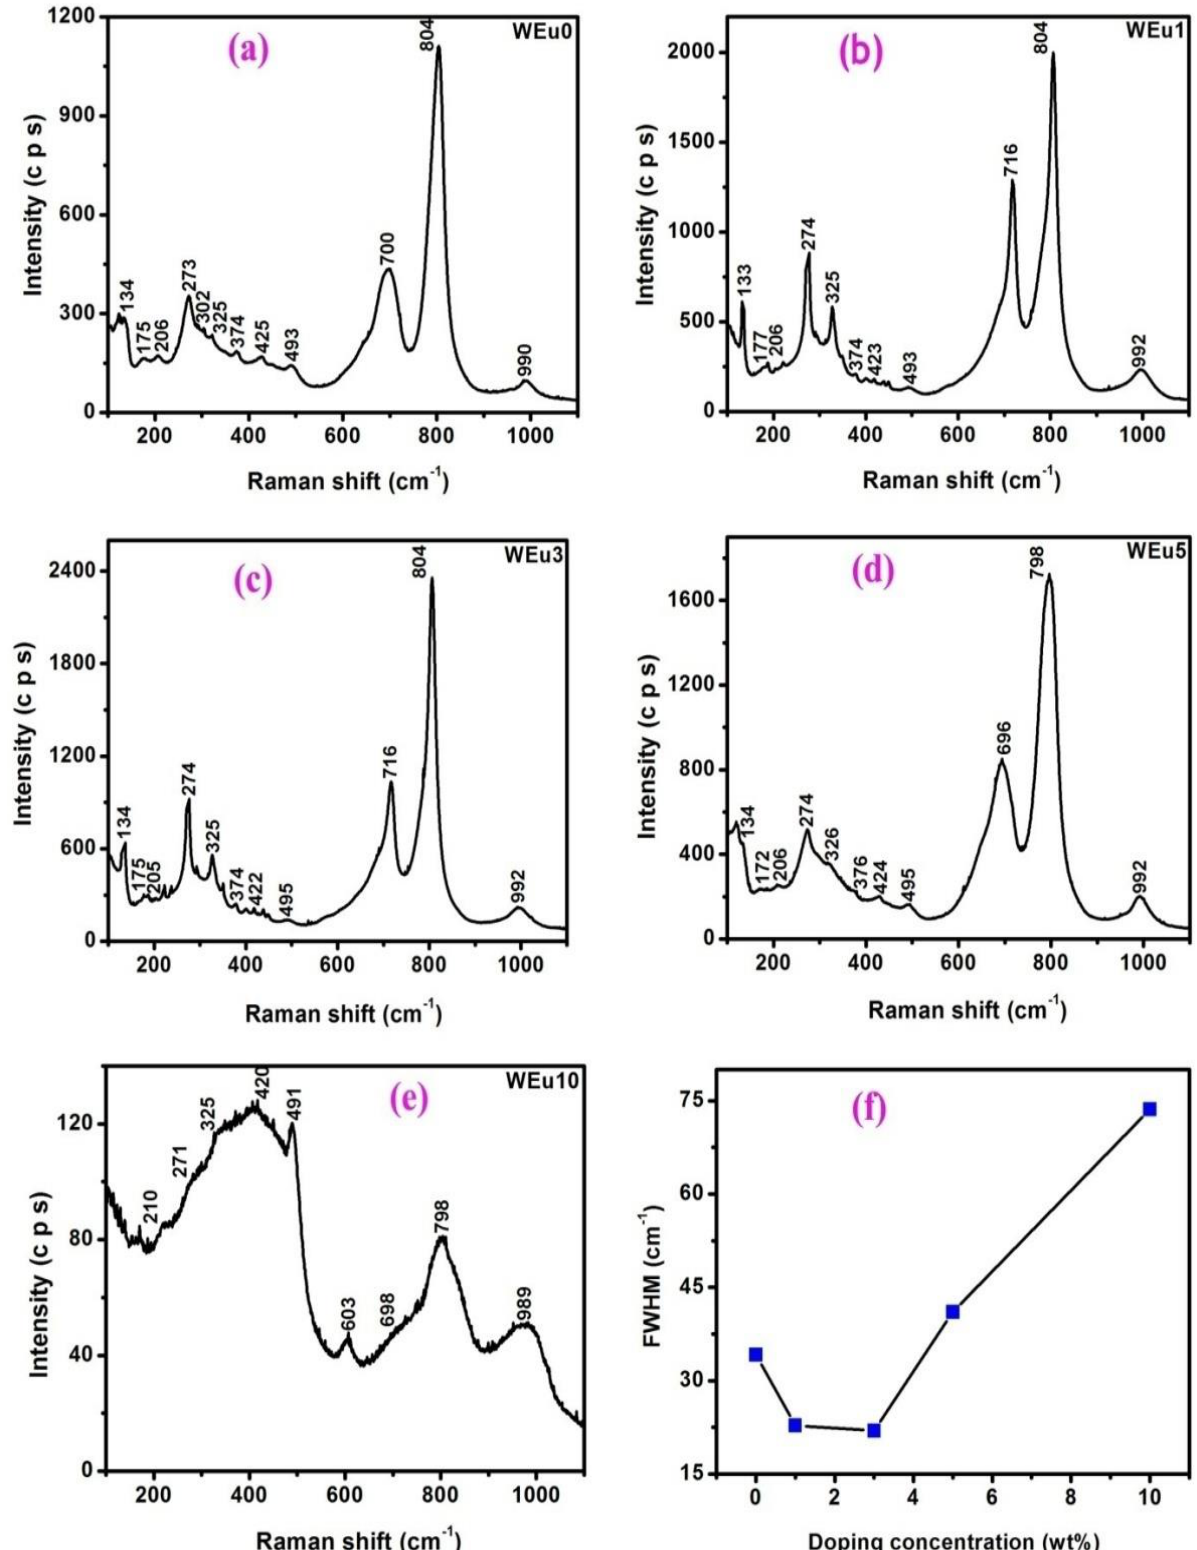
Figure 3. ( a – e ) Micro-Raman spectra of the un-doped and Eu 3+ -embedded WO 3 films annealed at 600 °C; ( f ) change in FWHM of the symmetric stretching mode (around ~804 cm −1 ) as a function of Eu 3+ -doping content.